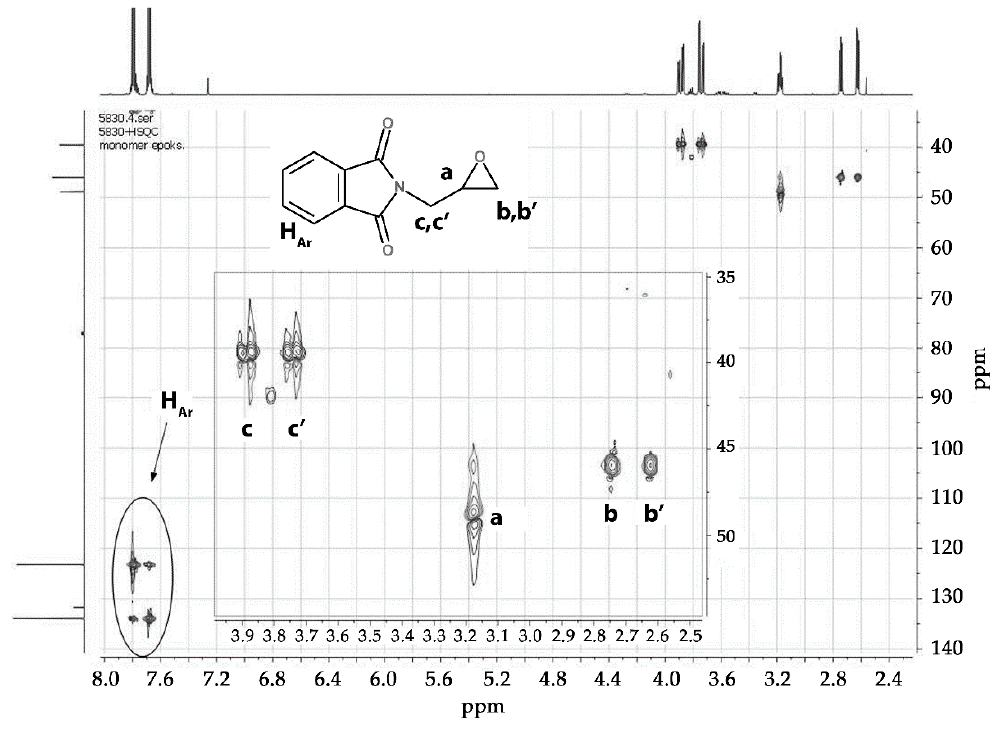
Figure 2. The 1 H– 13 C HSQC—DEPT (500 MHz, DMSO–d 6 ) NMR spectrum of epoxy phthalimide monomer.